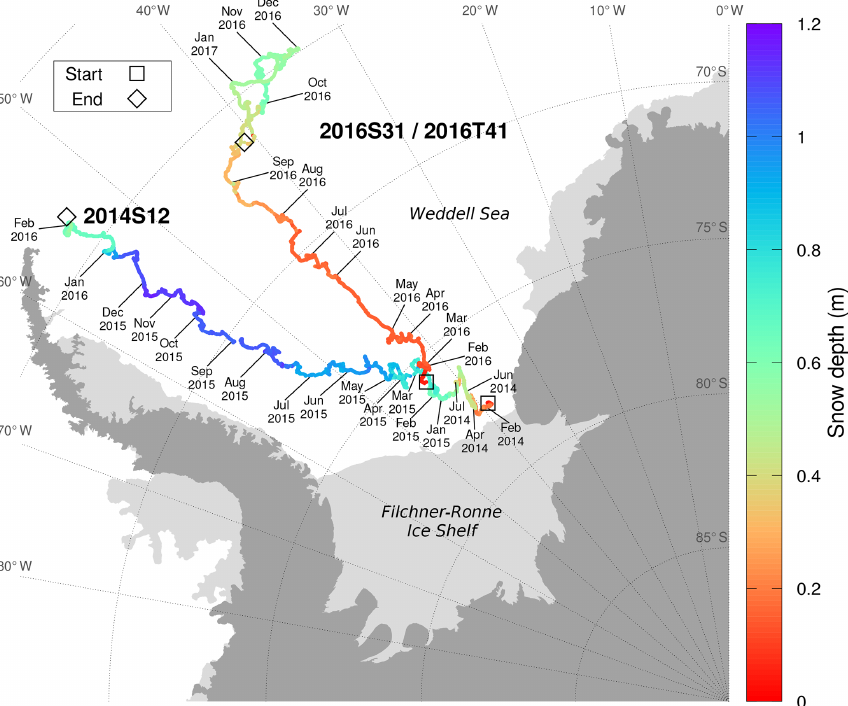
Figure 1. Trajectories of the two snow buoys used for the simulations. The average snow depth measured by the four snow depth sensors from each snow buoy is shown in color. Labels show the position of the respective snow buoy on the first day of the month. For buoy 2014S12, some labels at the beginning have been omitted for readability. The deployment location (start) is denoted by a square; the location of the last received data from the buoy (end) is denoted by a diamond. The collocated IMB for the 2014S12 snow buoy (2014T9) stopped transmitting data shortly after installation and is ignored in the analysis. The collocated IMB to snow buoy 2016S31 is